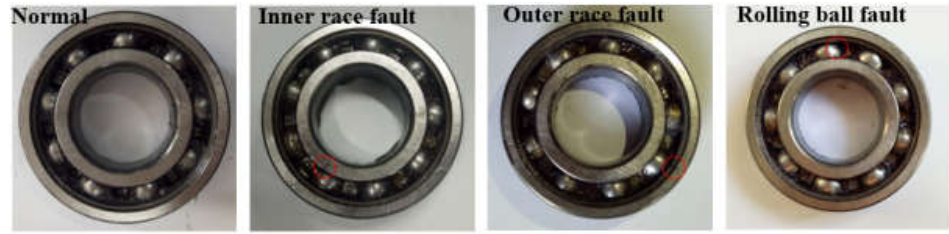
Figure 4. Different health states of rolling bearings.